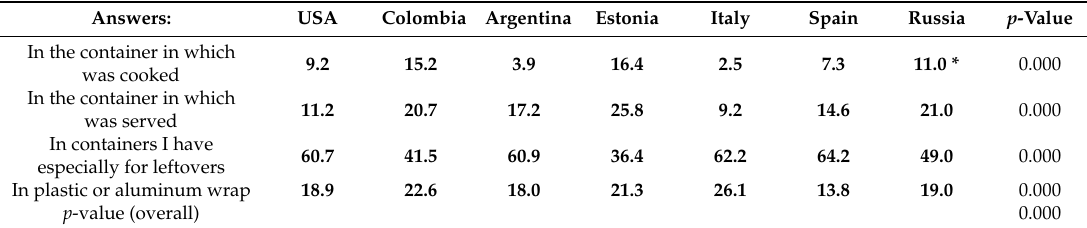
Figure 4. How do you usually store leftover food in the refrigerator? (Check all that apply.) Results presented for males and female in each country, by count. Table 5. How do you usually store leftover food in the refrigerator? (Check all that apply.) Results given in % of respondents.